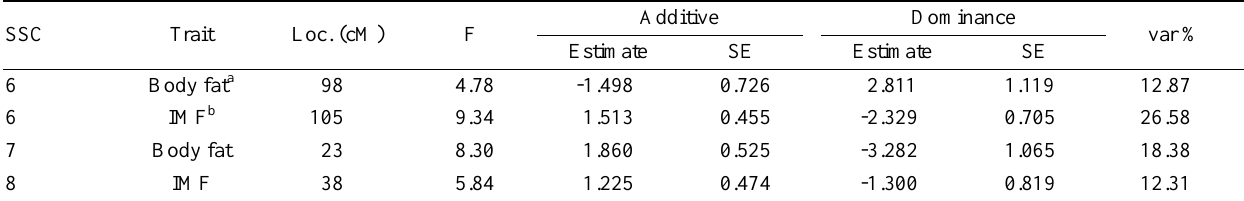
Table 2. Chromosome-wide significance and suggestive associations of chromosomal regions with fat deposition traits SSC